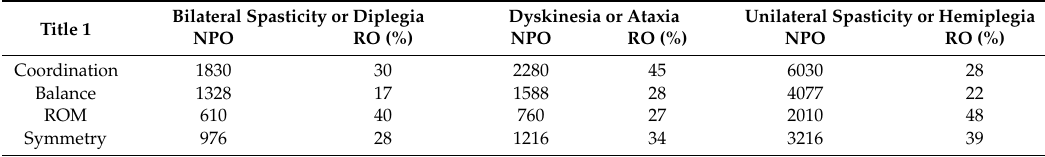
Table 4. The number of observations recorded from the qualitative